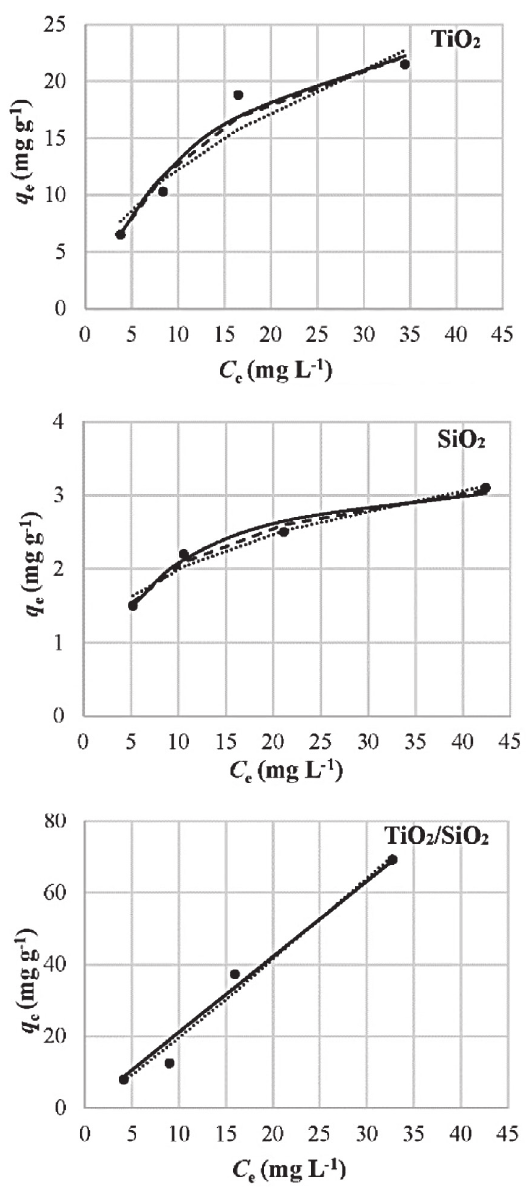
Fig. 4 – Experimental equilibrium adsorption isotherms ( • )